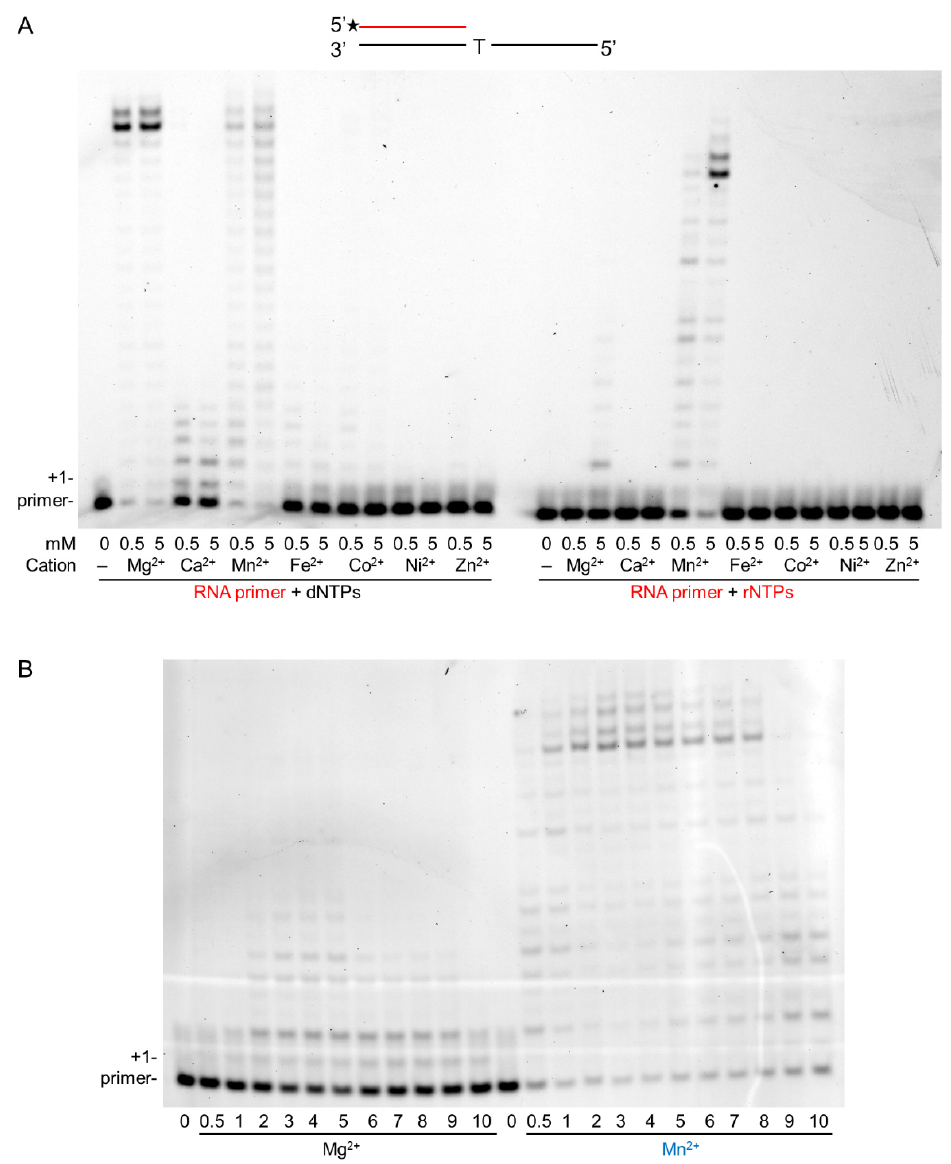
Figure 1. Manganese activates the RNA synthetic activity of hPol η . ( A ) Primer extension reactions were performed applying two different concentrations of the indicated divalent cations. The structure of the primer/template used in the experiments is shown on the top. The black line depicts a DNA strand, and the red line is an RNA strand. The asterisk indicates a fluorescent label. The first templating nucleotide is shown. Reactions contained 30 nM Pol η , 20 nM primer/template, and either 50 µ M of dNTPs (left panel) or 1 mM of rNTPs (right panel). The positions of the primer and its one nucleotide extension are indicated. ( B ) Mg 2+ and Mn 2+ concentration-dependent RNA extension. Reactions were performed for 10 min with 20 nM hPol η in the presence of 20 nM RNA/DNA and 1 mM rNTPs. The concentrations of Mn 2+ and Mg 2+ are indicated below each